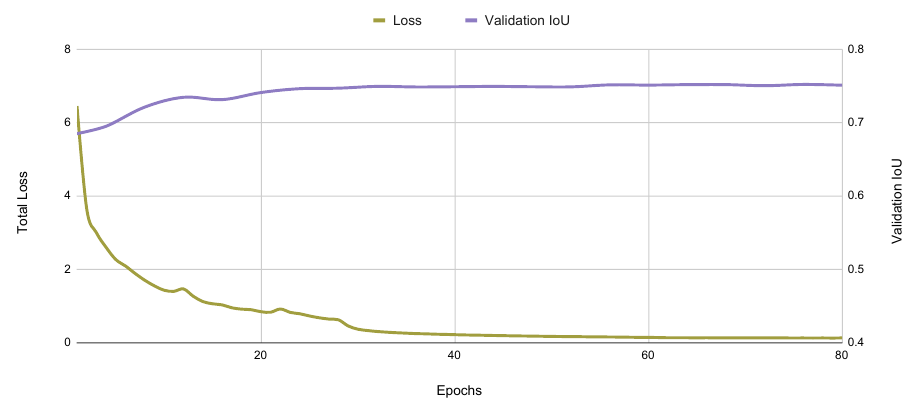
Figure 7. Typical learning curve for the Yolact++ algorithm, showing the evolution of training loss and the validation IOU.